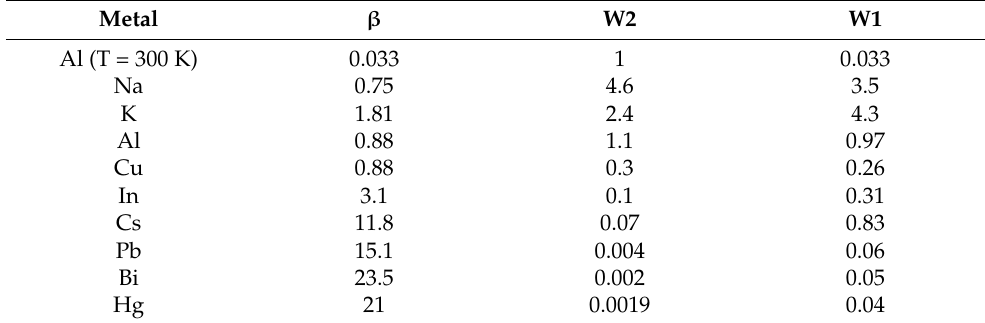
Table 6. Efficiency of transformation of fields in metals